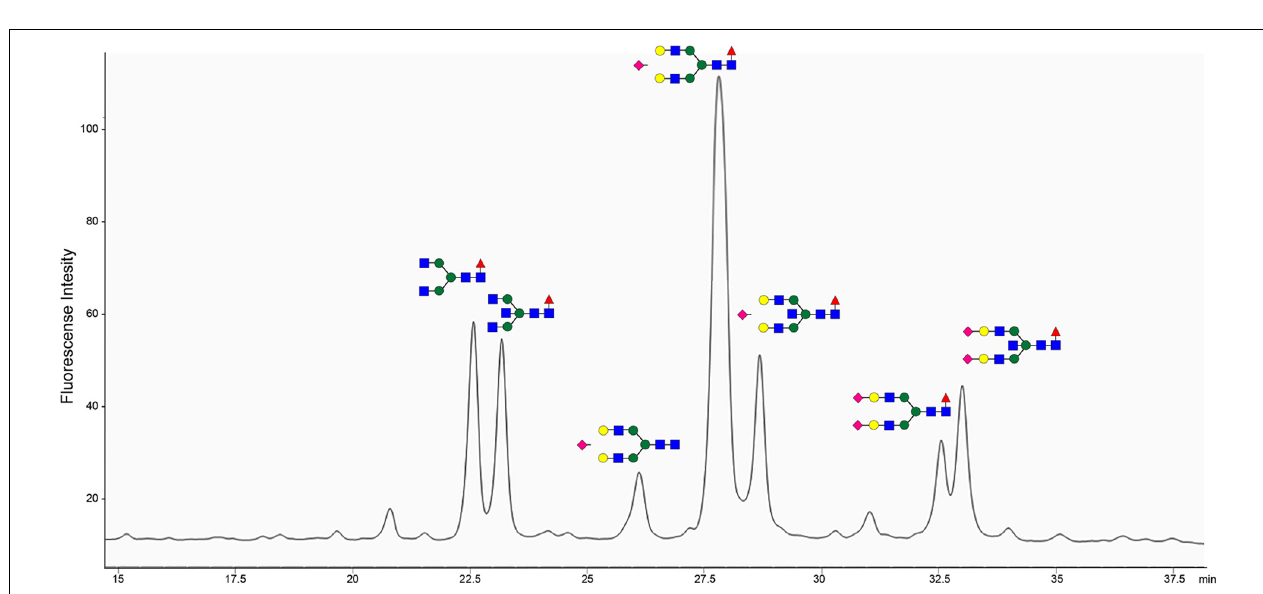
FIGURE 9 | pIgA N-linked glycans are primarily represented by extended biantennary structures. HPLC of 2-AB labeled glycans of the pIgA Fc-tail cleaved by BspE, followed by glycan release with PNGaseF. Characterized N-glycan structures are annotated using the nomenclature of the Consortium for Functional Glycomics (blue square: N -Acetylglucosamine, green circle: mannose, yellow circle: galactose, purple diamond: sialic acid, red triangle: fucose). Site-specific characterization of 2-AB labeled pIgA N- glycosylation at position Asn 459 by High Pressure Liquid Chromatography (HPLC). The y-axis indicates fluorescent intensity and the x-axis shows the retention time the individual